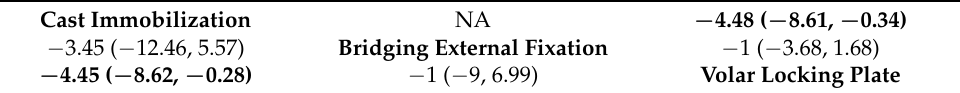
Table 2. Absolute and relative mean difference estimates (95% CI) on PRWE questionnaire. Upper right triangle gives the mean difference from pairwise comparisons (column intervention relative to row) and lower left triangle gives the mean difference from the network meta-analysis (row intervention relative to column).